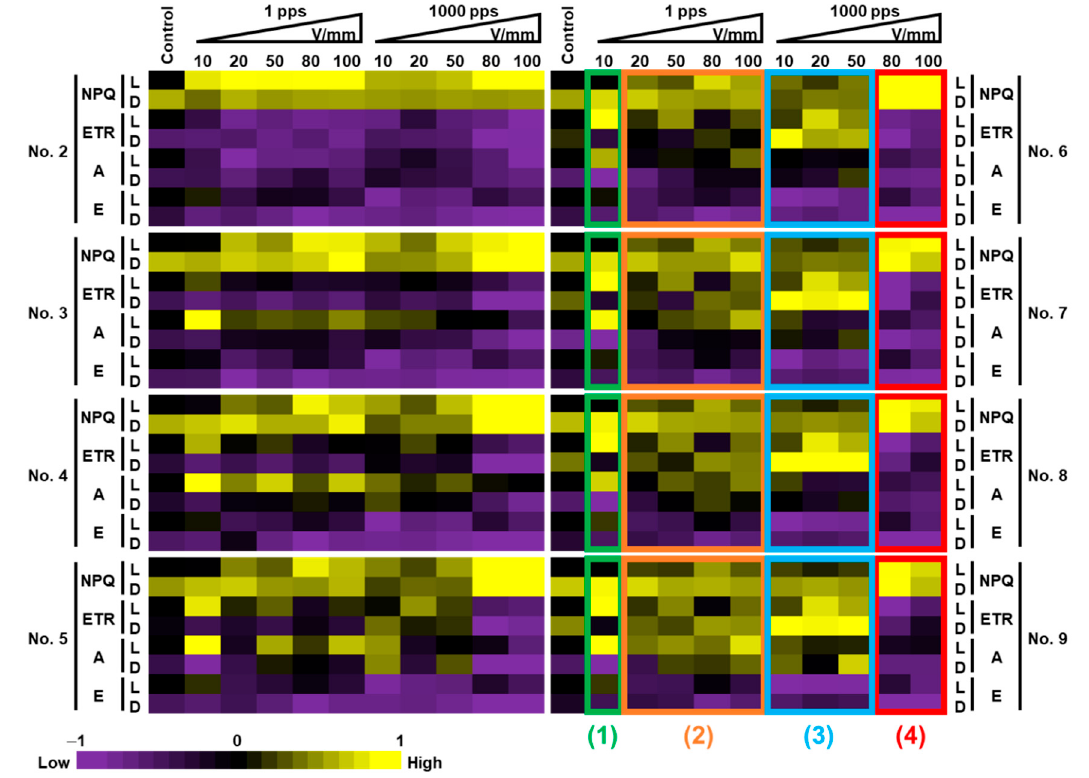
Figure 7. Heatmaps of photosynthetic parameters for lettuce leaves treated with PEF. The heatmaps were drawn using the average values of 15 samples for the control and 5 samples for each PEF-treated group. For each measurement time point (No.) and photosynthetic parameter (NPQ, ETR, A, E), the maximum absolute value of the difference between the control samples and PEF treated samples was set to 1. L: light-acclimated PEF samples; D: dark-acclimated PEF samples. Figure 8 is a heatmap of photosynthetic rate (A) made using the E t values calculated